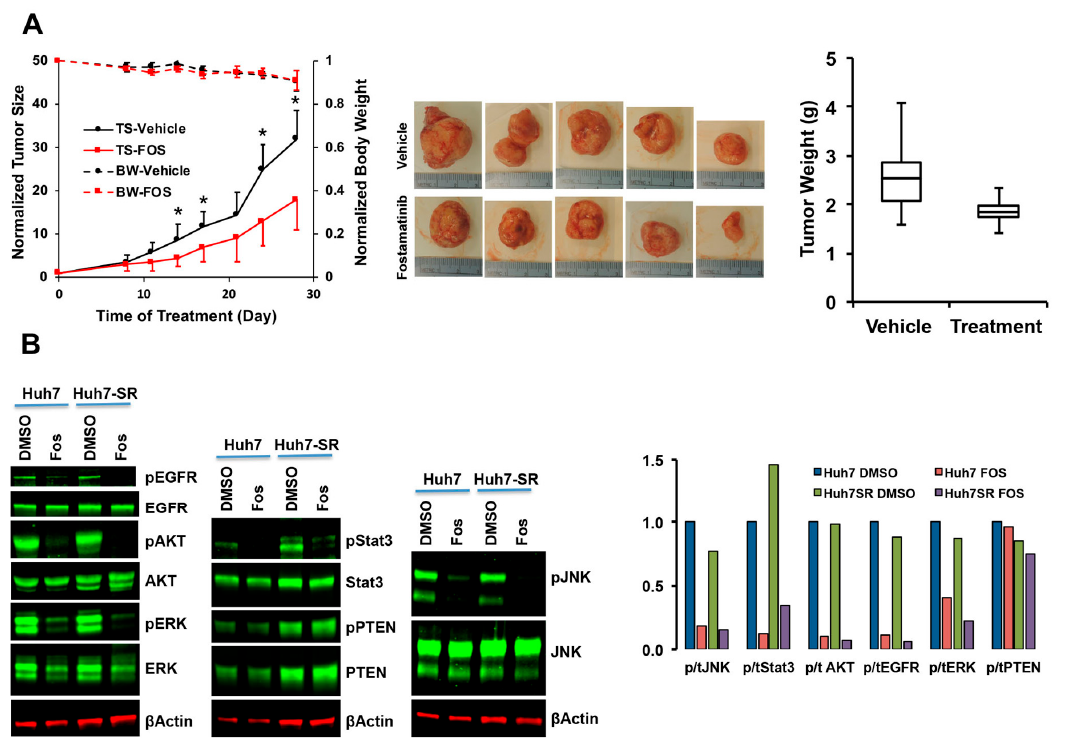
Figure 5. In vivo efficacy of fostamatinib and signaling pathway. ( A ) NSG mice bearing subcutaneous tumors of MHCCLM3 cells were treated with vehicle or fostamatinib (Fos) for 4 weeks. Body weights of tumor-bearing mice (BW) and size of the tumor (TS) during treatment, as well as pictures of tumors and tumor weights at the end of the treatment, are provided. ( B ) Western blot analysis of indicated proteins and quantification of phosphorylated protein normalized to total protein in Huh7 and Huh7-SR cells treated with vehicle (DMSO) or fostamatinib (Fos). Uncropped Western blots are shown in Figure S7. * indicates a statistically significant difference between the two groups at p = 0.05.